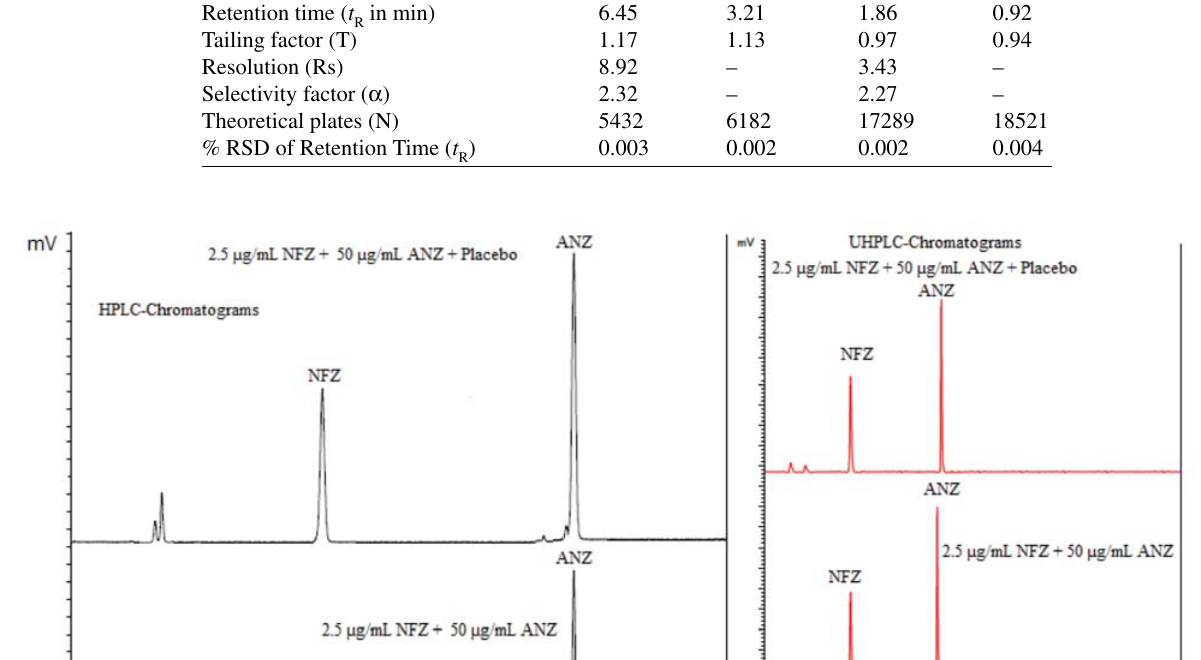
Ali et al.: Stability Indicating UHPLC-PDA Assay ...